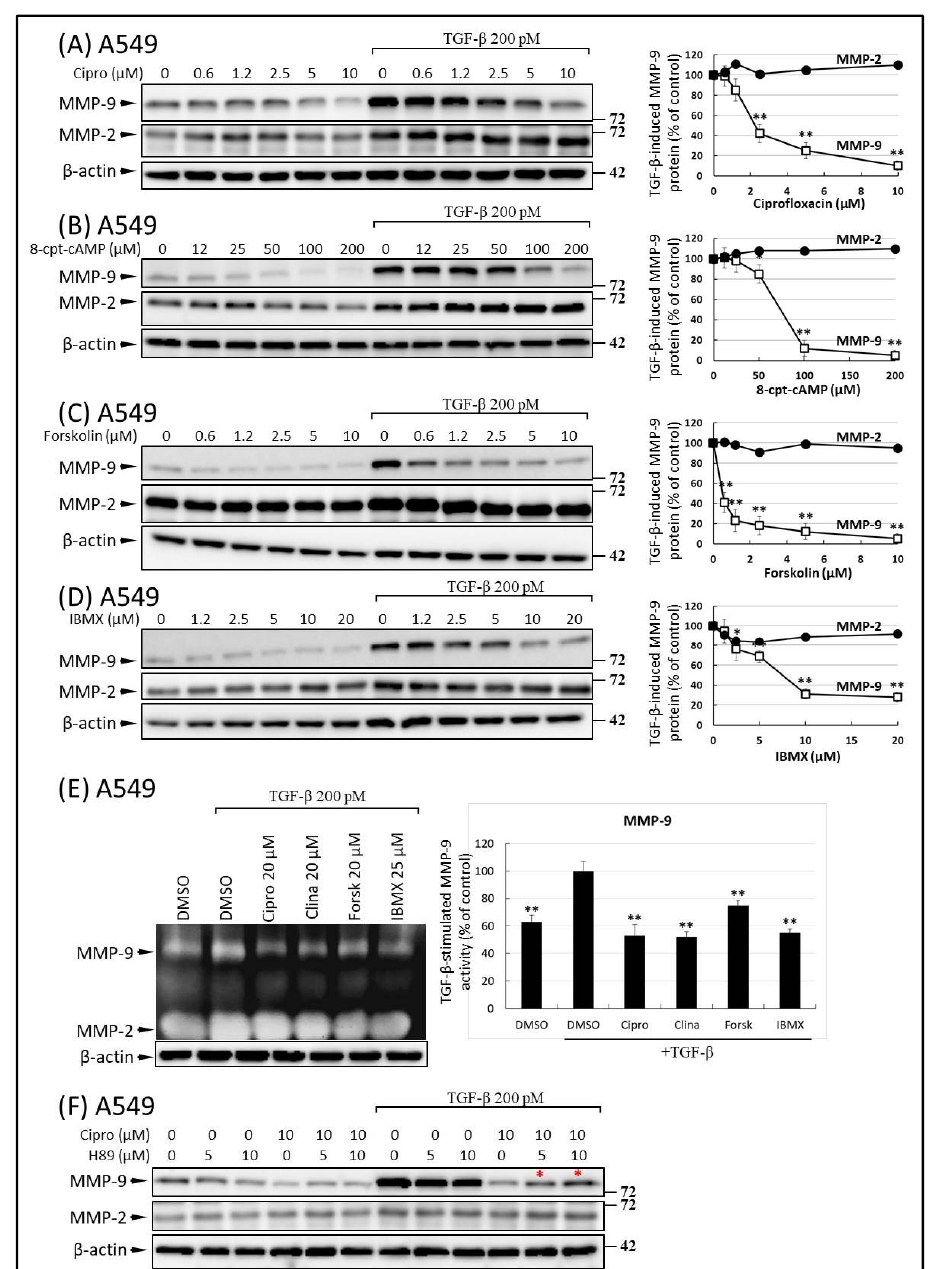
Figure 7. Effects of ciprofloxacin and cyclic AMP mimetics on transforming growth factor beta (TGF- β )-induced secretion of matrix metalloproteinase-9 (MMP-9). Cells were preincubated with increasing concentrations of ( A ) ciprofloxacin, ( B ) 8-cpt-cAMP, ( C ) forskolin, and ( D ) isobutyryl methylxanthine (IBMX) prior to the addition of 200 pM TGF- β for 48 h. MMP-9 protein levels were determined in the culture medium by Western blot analysis. For details see the legend to Figure 3 and Materials and Methods (Section 4.5). Data are presented as mean ± standard deviation ( n = 3). * p ≤ 0.01, ** p ≤ 0.001 vs. control (TGF- β stimulated cells). ( E ) Inhibitory effect of clinafloxacin and cAMP on MMP-9 activity in TGF- β stimulated A549 cells ( n = 3). Cells were incubated with ciprofloxacin, clinafloxacin, forskolin, and IBMX at the indicated concentrations prior to addition of 200 pM TGF- β for 48 h. MMP-9 activities were determined in the culture medium by gelatin zymography. ( F ) H89, a protein kinase A inhibitor blocks the inhibitory effect of MMP-9 on ciprofloxacin release. A549 cells were incubated with or without H89 (5 and 10 µ M) for 15 min, then with or without ciprofloxacin (10 µ M) for 5 min, and then continued with or without TGF- β (200 pM) for 48 h. The conditioned medium was analyzed by Western blotting and densitometry. ( F ) A representative image revealed that H89 alone or